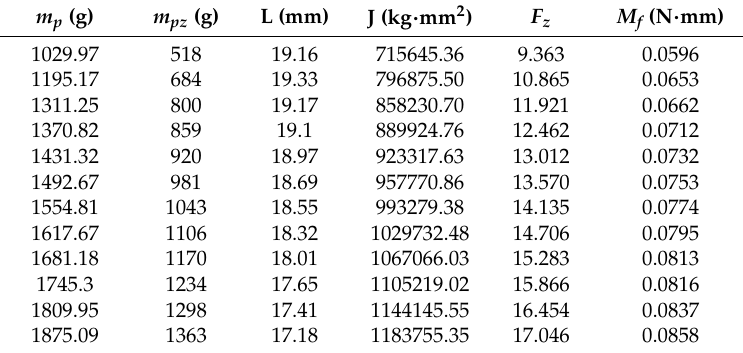
Table 5. Simulation